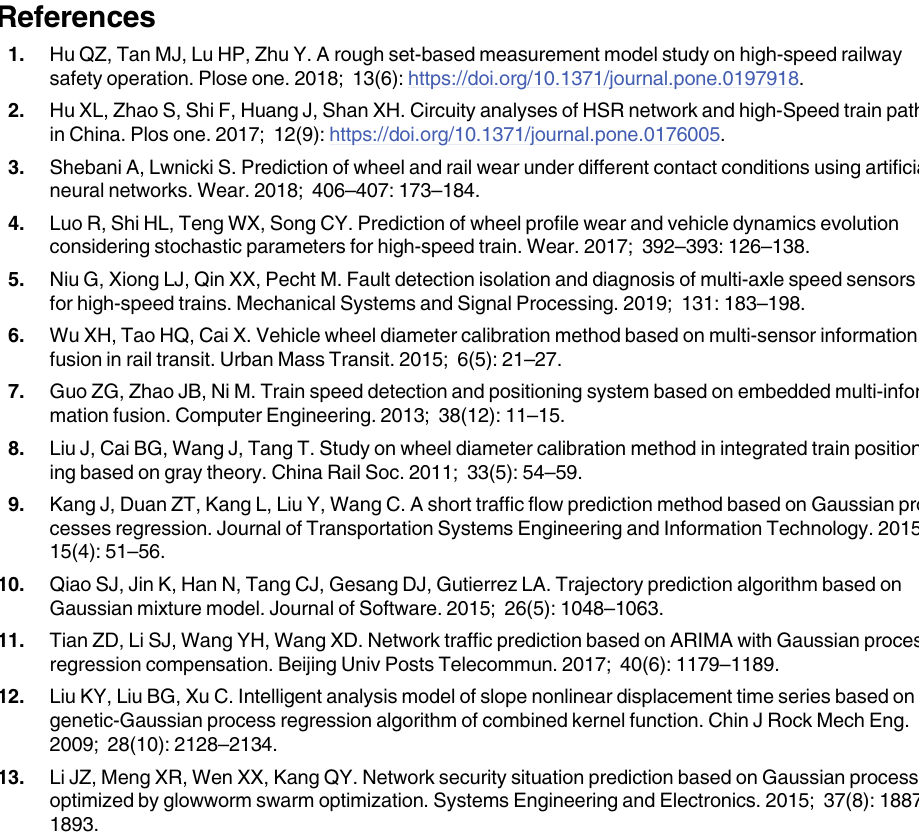
S1 Table. DF11 locomotive wheel diameter measurement report